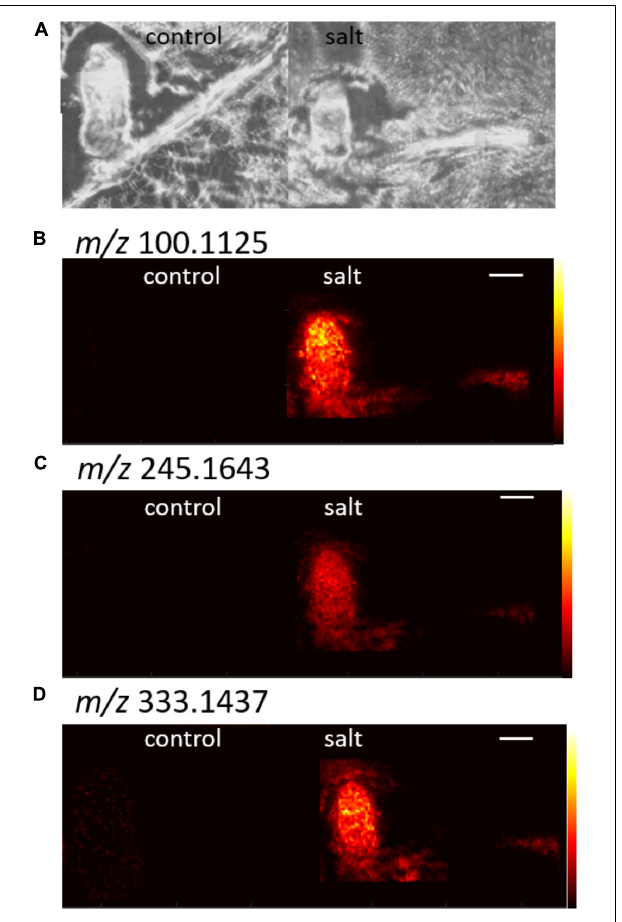
FIGURE 6 | Example images for selected m/z ions in salt treated nodules with AUC values above 0.75. The optical image is shown in (A) and (B–D) show three different m/z . CHCA was the matrix for all images shown. The white scale bar indicates 1 mm.